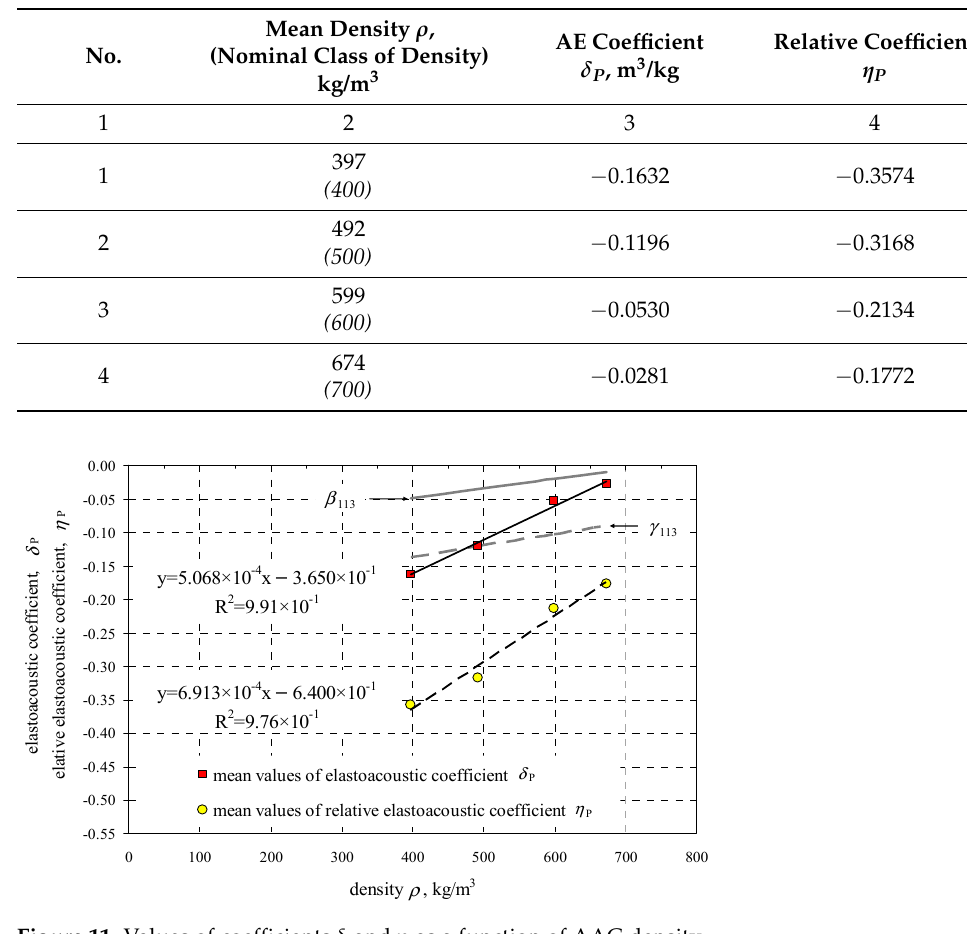
Figure 11. Values of coefficients δ and η as a function of AAC density.